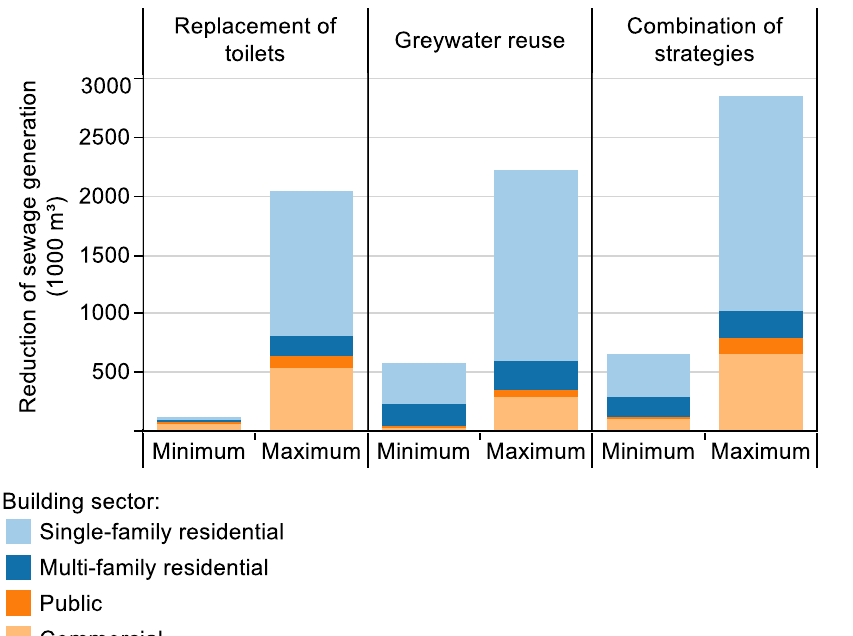
Figure 4. Minimum and maximum reductions of sewage generation due to each strategy.